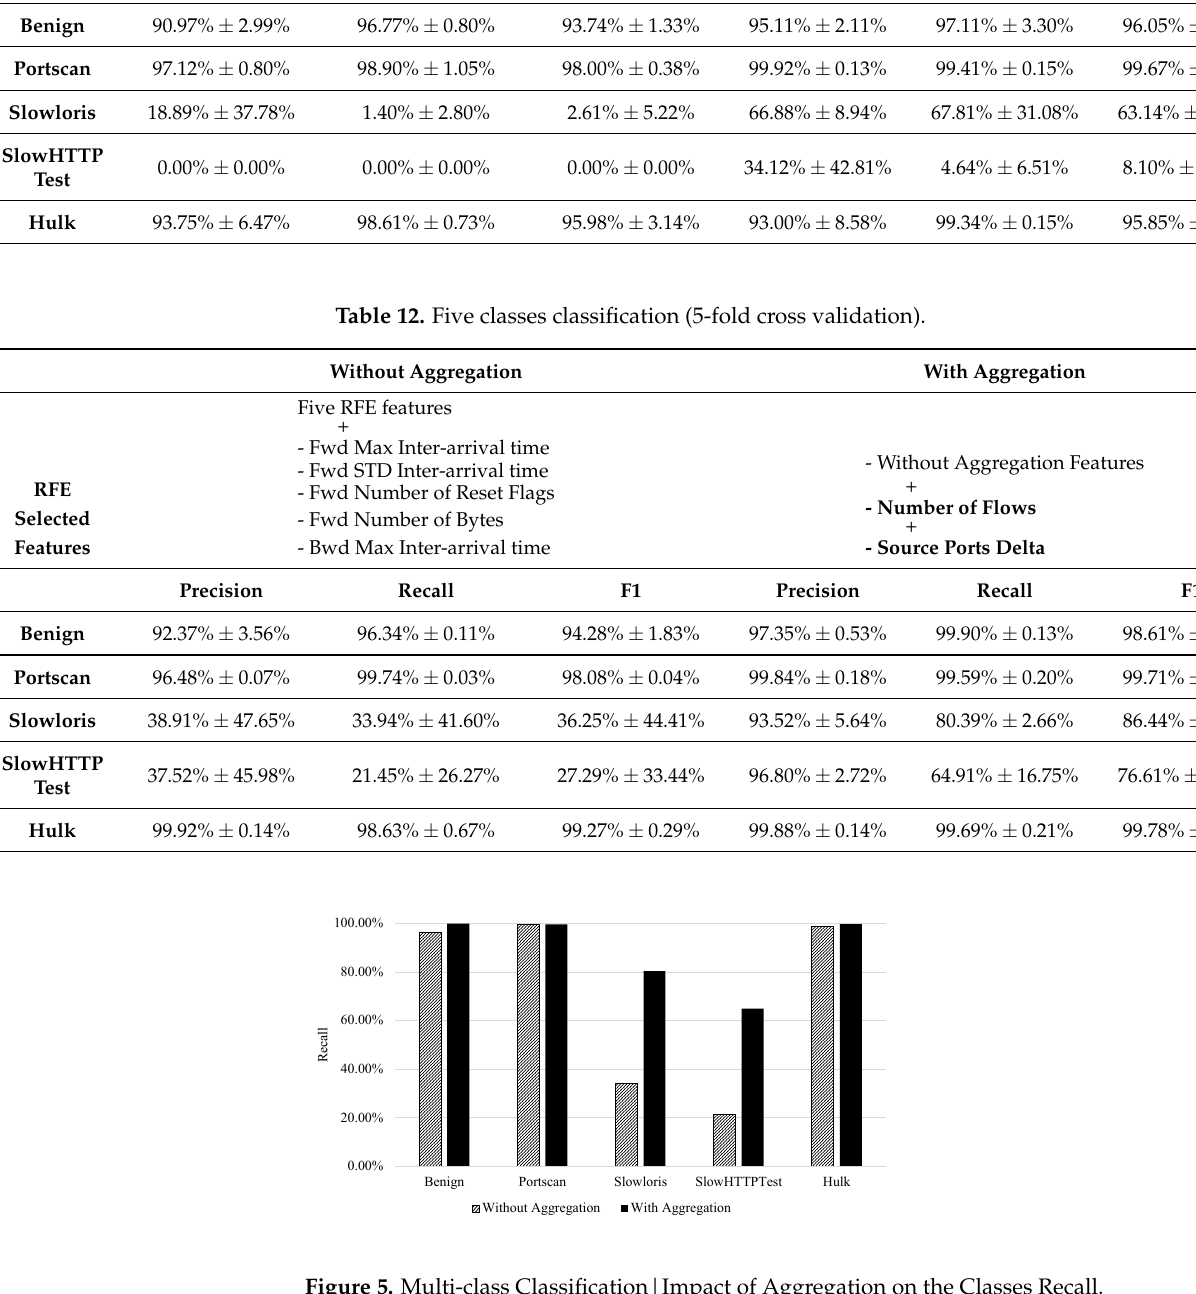
Figure 5. Multi-class Classification|Impact of Aggregation on the Classes